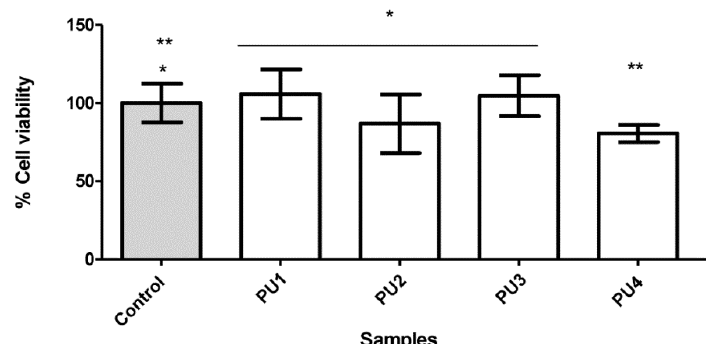
Figure 11. The HaCaT cell viability by MTT after proliferation under polyurethanes PU1 – PU4 . Control (glass slide). (mean ± SD) ( n = 6). (* Not significantly different ( p > 0.05), ** significantly different ( p ˂ 0.05)).